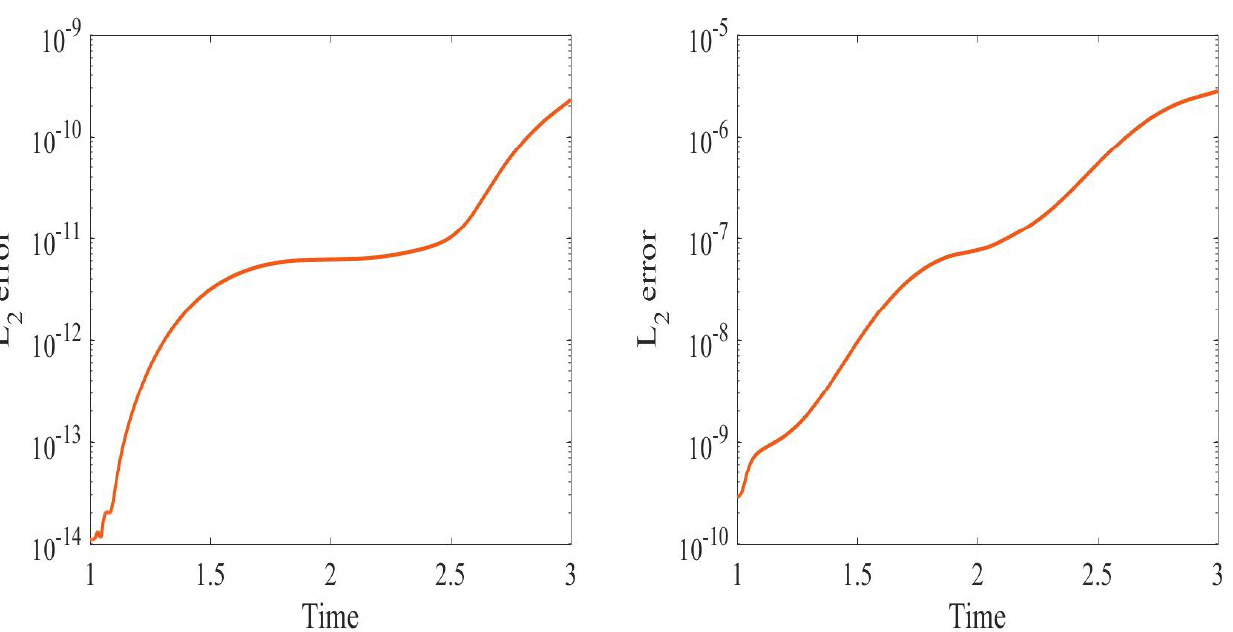
Figure 7. Mean L 2 error ( left ) and variance L 2 error ( right ) for the inviscid Burgers’ equation at t f =3 and switching time t s =1 with the number of modes N =4